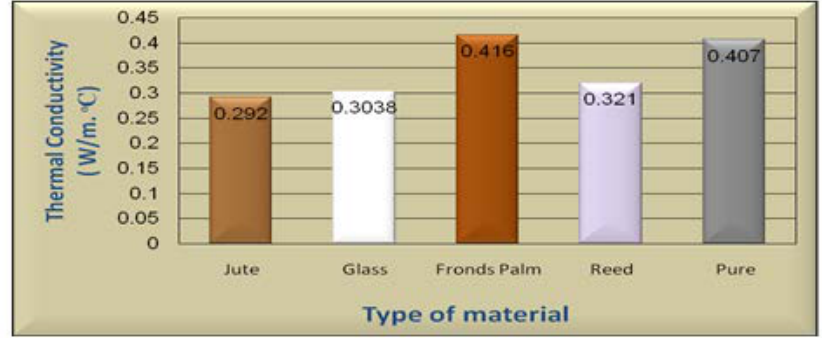
Fig.8: Comparison between the thermal conductivity for natural fibers with Glass fibers composites.